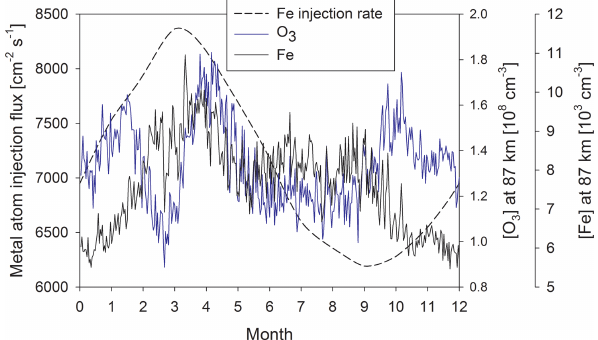
Figure 8. Monthly variations of the injection flux of Fe from me- teoric ablation and the concentrations of O 3 and Fe at 87km (aver- aged from 2009 to 2015) predicted by